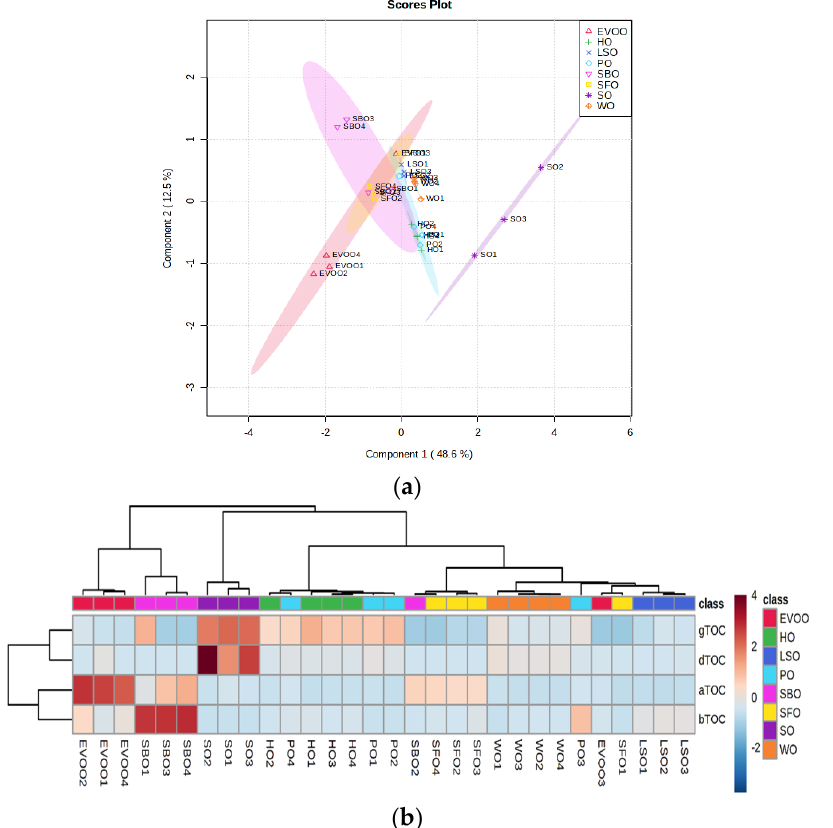
Figure 4. ( a ) PLSDA score plot for the discriminatory analysis of the eight classes of oils, considering their tocopherol contents. ( b ) Heatmap representing the Euclidian distance using the Ward algorithm to identify the similarities between individual oils.